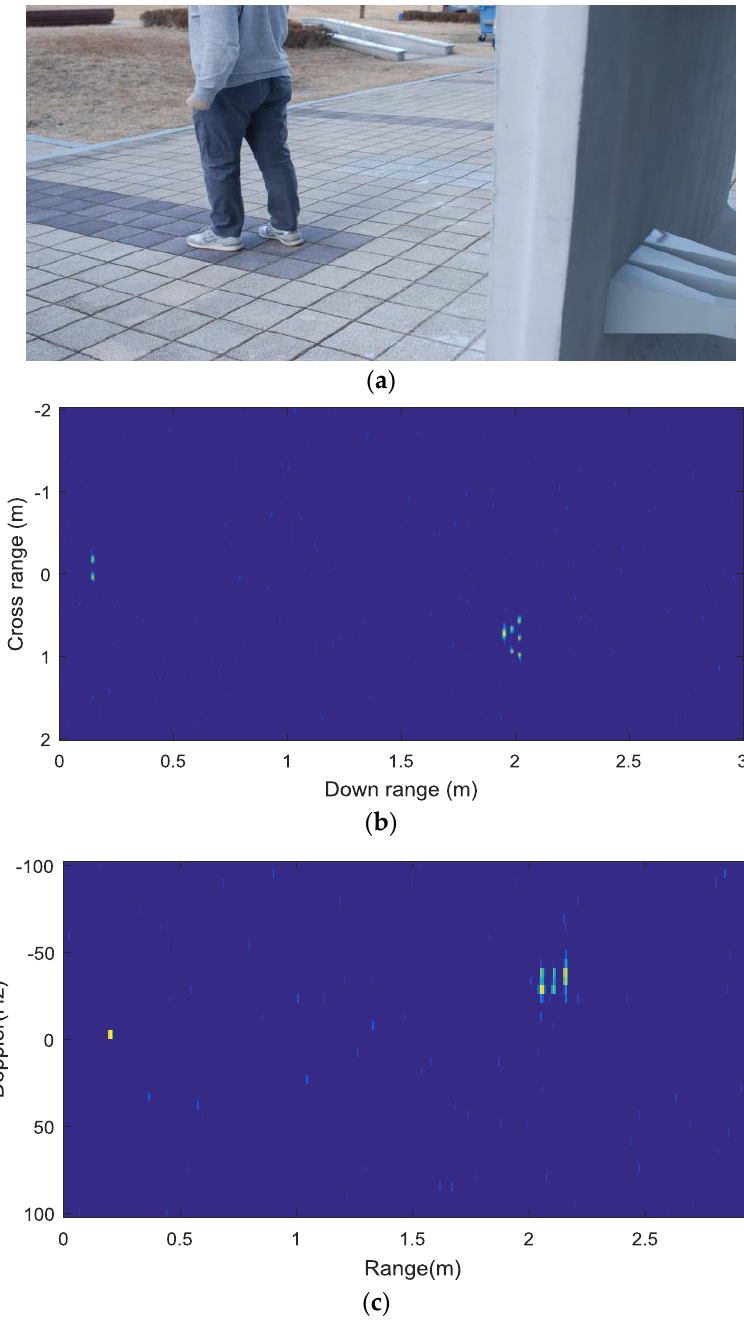
Figure 13. ( a ) Imaged scene for person detection. ( b ) One frame of the detection results when 𝑀̂ = 8. ( c ) One frame of Range-Doppler maps, showing the Doppler frequency.